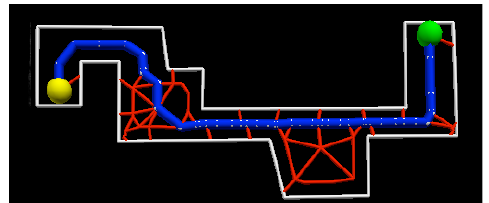
Figure 7. Best path comparison between Door-to-door and